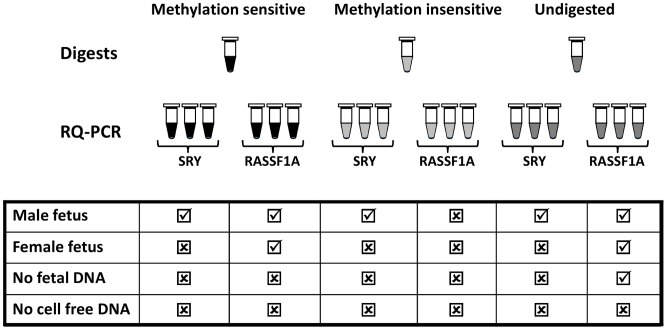
Schematic representation of the possible results obtained using hypermethylated RASSF1A as a universal fetal marker when determining fetal sex by NIPD for a male fetus, female fetus, a case where no cell free fetal DNA is present and a case where no total cell free DNA is present.Ticks represent the presence of amplified products from either the SRY assay or the RASSF1A assay. Crosses represent no amplification of SRY or RASSF1A amplicons.